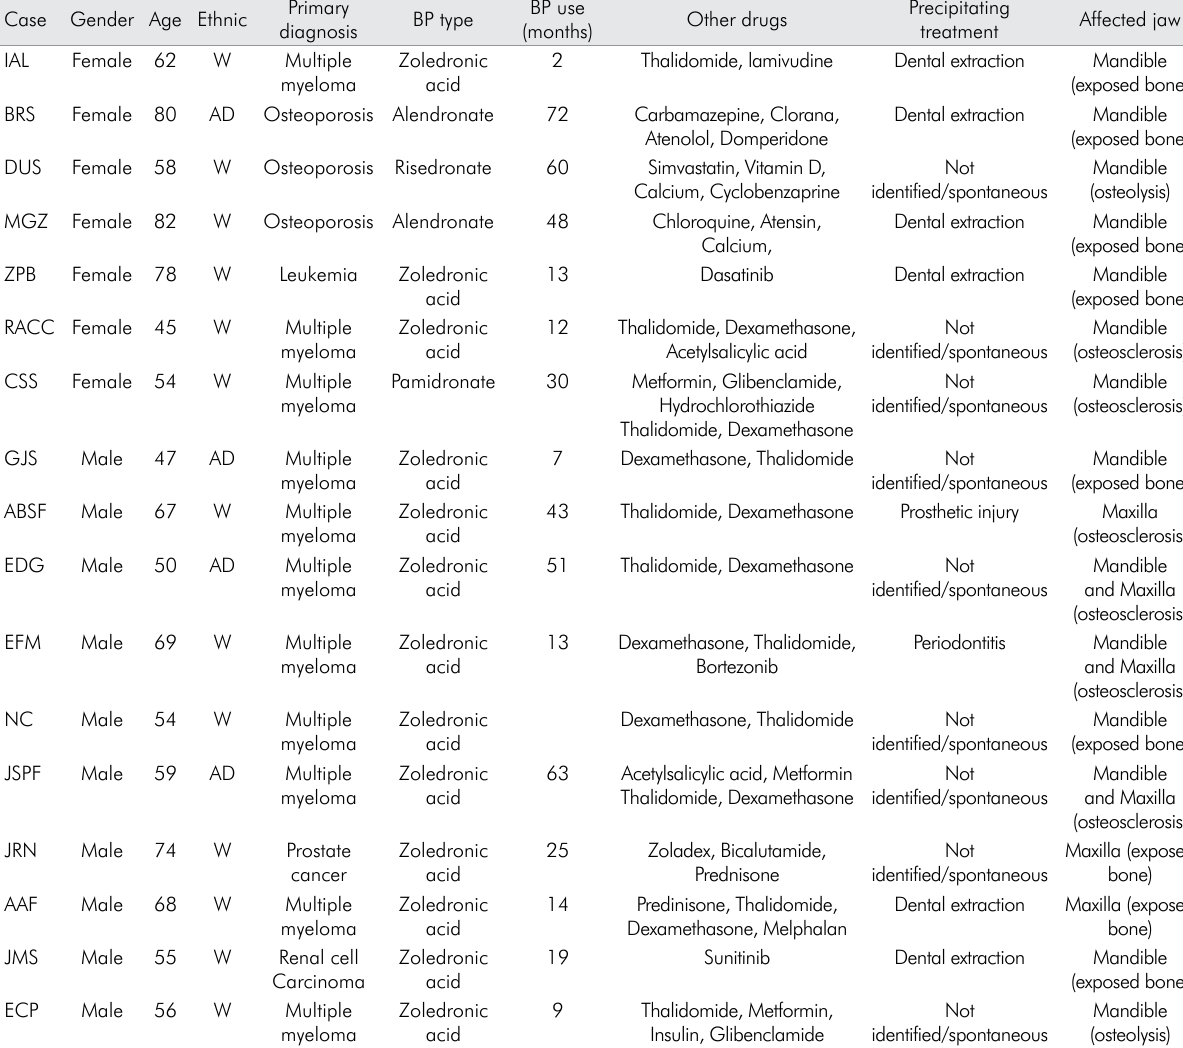
Table 1. Demographic and clinical data of BRONJ patients. Case Gender Age